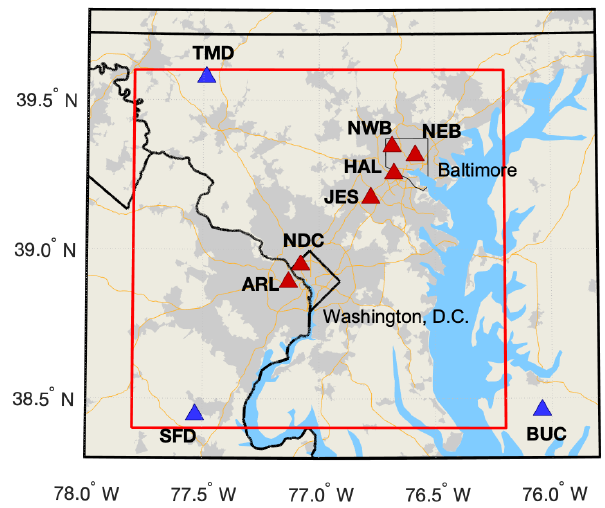
Figure 1. Domain of interest for our study (red square), surround- ing the metropolitan regions of Washington, DC, and Baltimore, MD. Gray shading indicates U.S. Census-designated urban areas (http://www.census.gov, last access: 23 March 2017). Red triangles indicate urban stations used in this study, and blue triangles indicate background stations. All map data layers obtained from either Nat- ural Earth (naturalearthdata.com) or U.S. Government sources and in the public